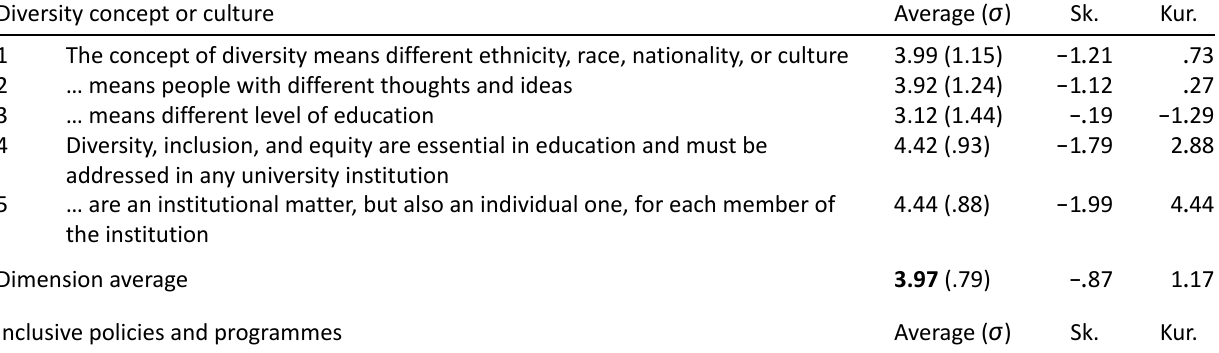
Table 2. Average, standard deviation, skewness, and kurtosis of the beliefs, attitudes, and practices related to the attention to